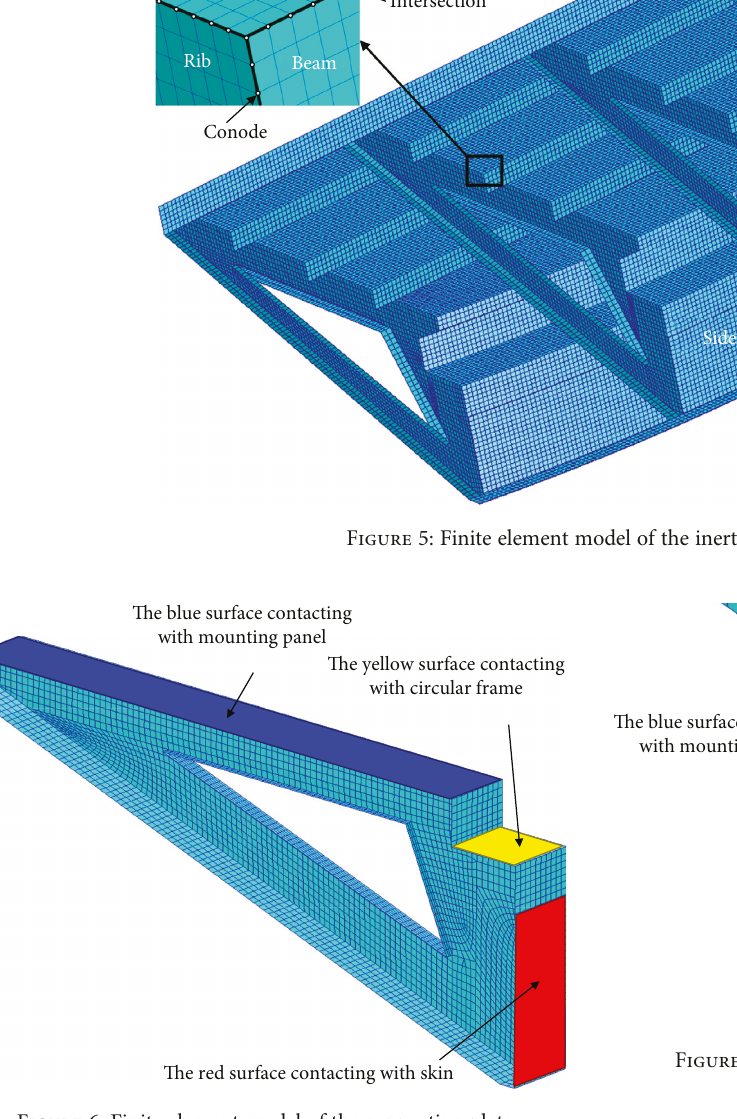
Figure 6: Finite element model of the supporting plate.